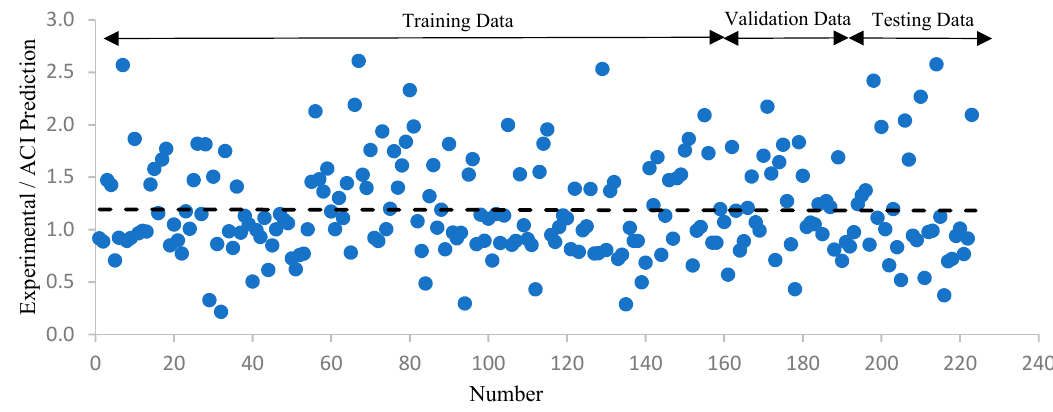
Figure 9. Experimental to ACI-predicted bond strength rations.